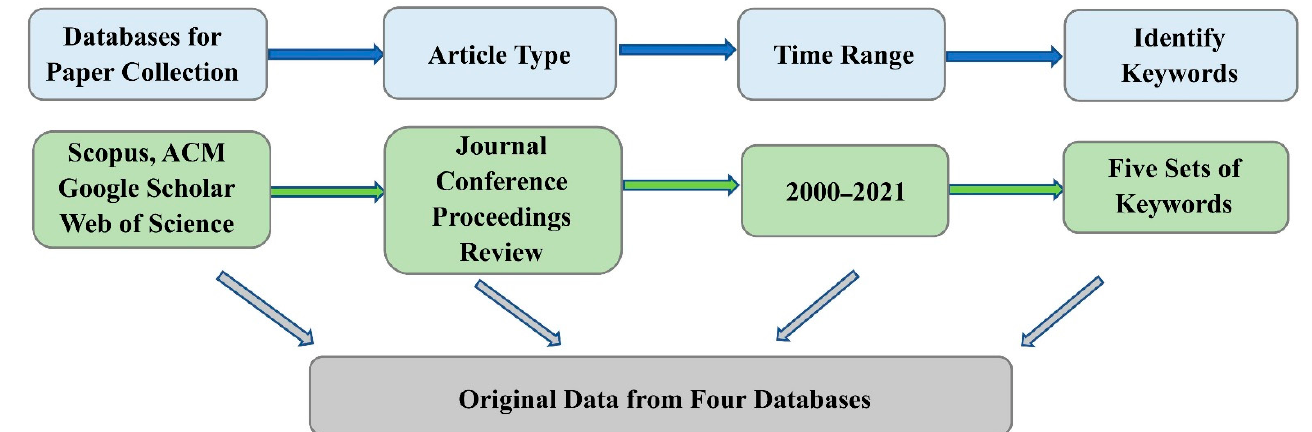
Figure 1. Paper retrieval process.